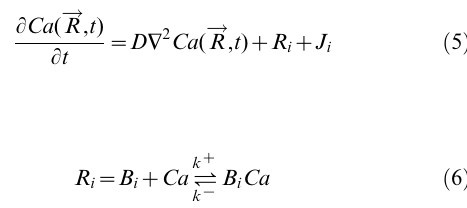
concentration in the middle of the j th shell, D r is the distance between shells, and the coefficients a, b, and c are shown in the legend of figure 12; R ij represent the chemical equations for Ca- assumed to diffuse also). These equations were solved with the binding to buffer B i and similar equations for diffusion of buffers. geometry of figure 12. The J i represents the flux of Ca 2 z into the Equation 7 was solved with a tridiagonal matrix decomposition ! into an upper and lower diagonal component such that for the is the vector from the center of cell through Ca 2 z channels and R